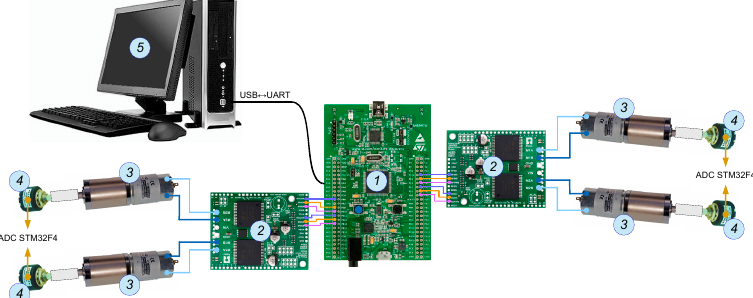
Figure 9. The diagram of control architecture.